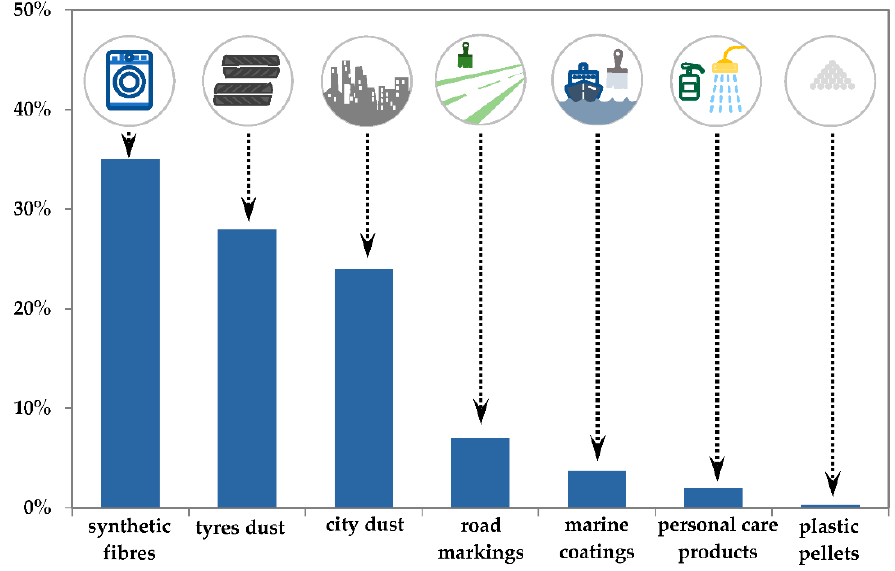
Figure 1. Global evaluation of sources for primary microplastics in the marine